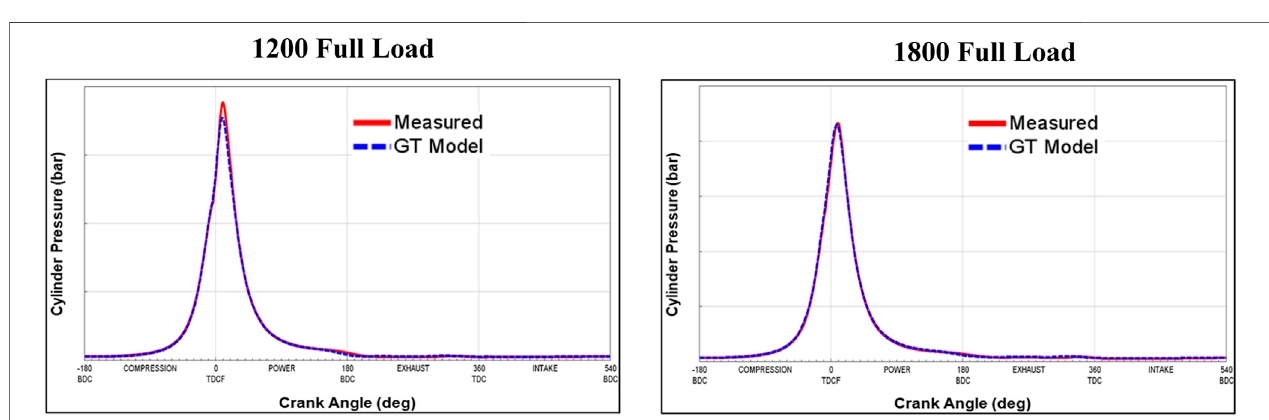
FIGURE 16 | GT model prediction for cylinder pressure compares well with measured data (EGR Pump plus Turbo Matching).